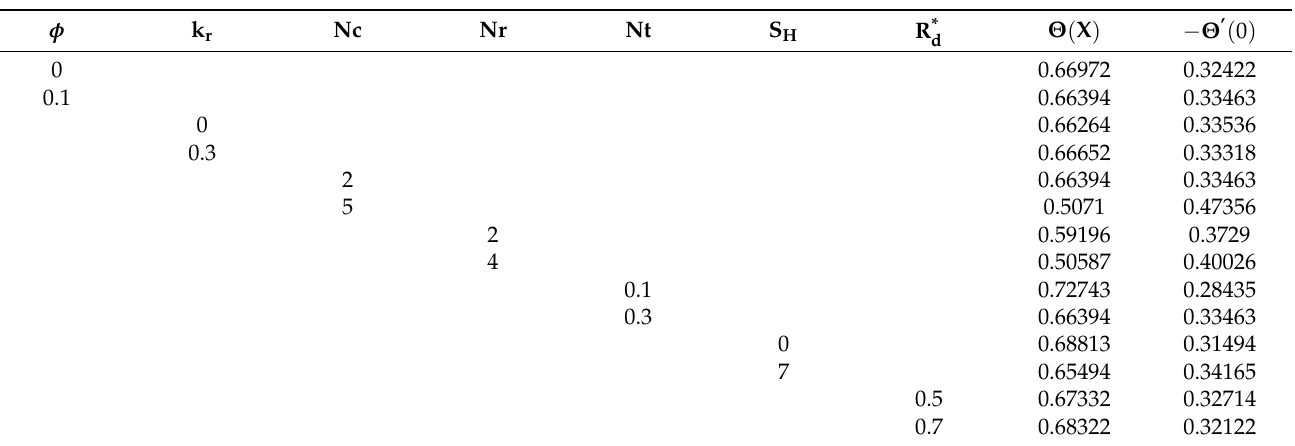
Table 2. Numerical values of Θ ( X ) (at X = 0.5) and − Θ (cid:48) ( 0 ) for different parameters when C = − 0.3, n = 0, Q int = 0.8, and γ = 0.1.